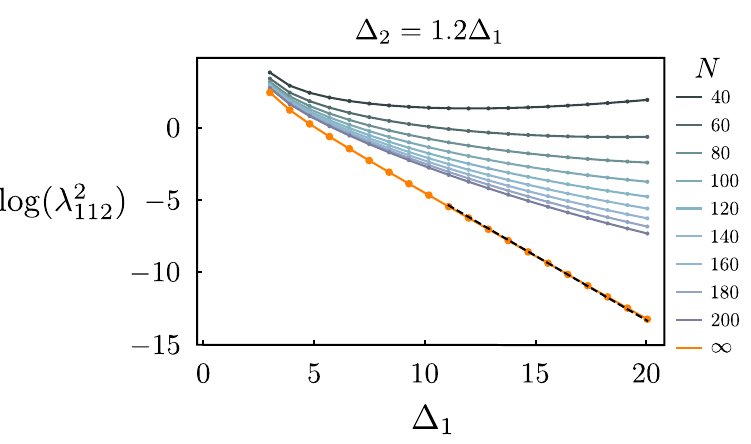
Figure 5 . Numerical bounds for scenario I in the speci(cid:12)c case with (cid:1) 2 = 1 : 2(cid:1) 1 . The orange line is the extrapolation of the numerical results to N = 1 and for large (cid:1) 1 it accurately matches the expected (cid:13)at-space slope as indicated by the dashed